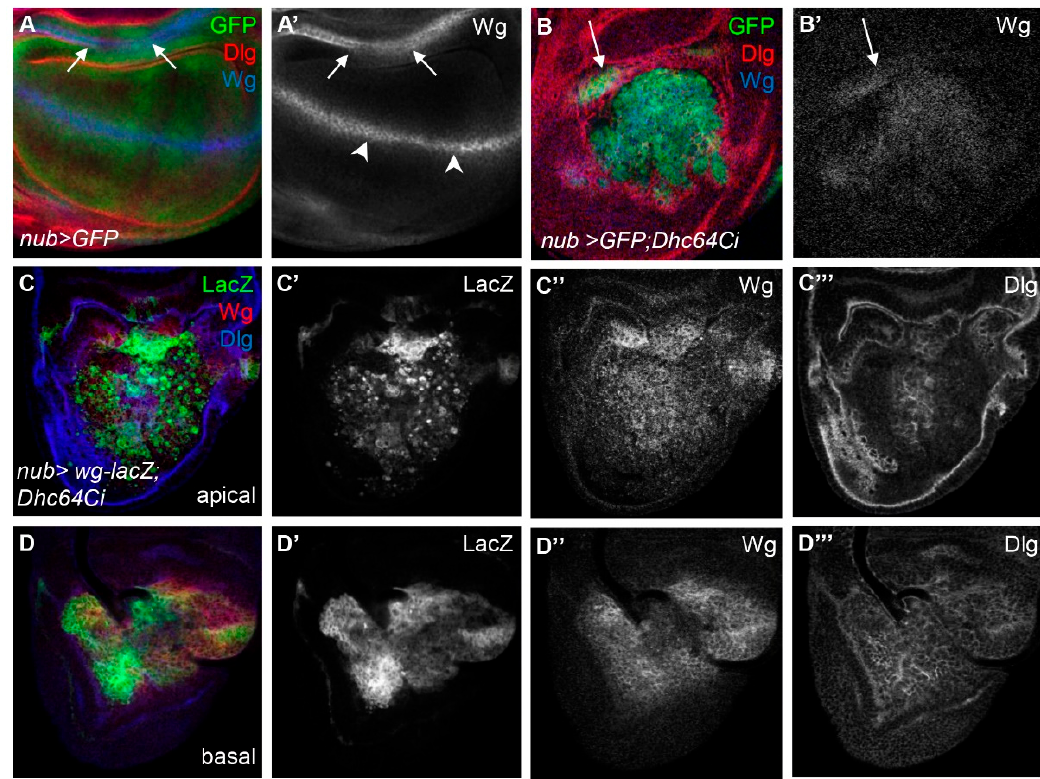
Figure 4. Knockdown of Dhc64C disrupts expression pattern of Wg. ( A-A’, B-B’ ) Knockdown of Dhc64C results in broad expression of Wg in the wing pouch. Pattern of Wg protein at the DV midline (arrowheads) and in the inner ring (arrows) in control wing disc ( A, A’ ) and extensively disorganized and widely distributed pattern of Wg in severely affected nub > GFP ; Dhc64Ci wing discs ( B, B’ ). ( C-C’’, D-D’’ ) The broad expression of Wg protein is due to widespread Wg-producing cells in both apical ( C-C’’ ) and basal ( D-D’’ ) regions of nub > GFP; Dhc64Ci wing discs.The expression pattern of the Dlg is also disrupted both in apical ( C’’’ ) and basal ( D’’’ ).